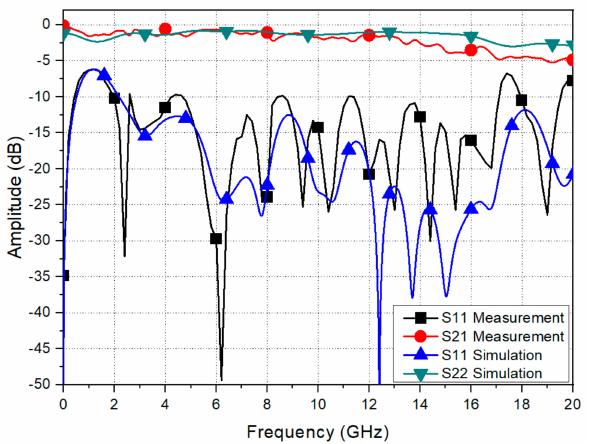
Figure 9. Simulated and measured S-parameters of the proposed compact CPS-to-MSL